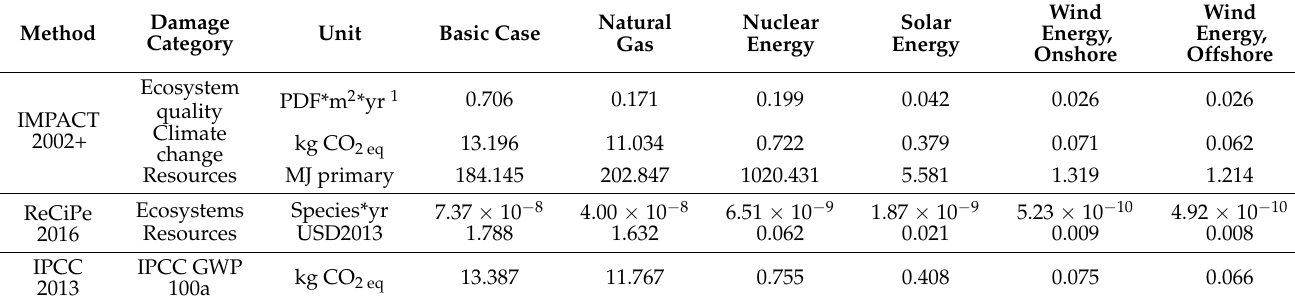
Table 13. Summary of impact assessment results for MED used with different energy sources.